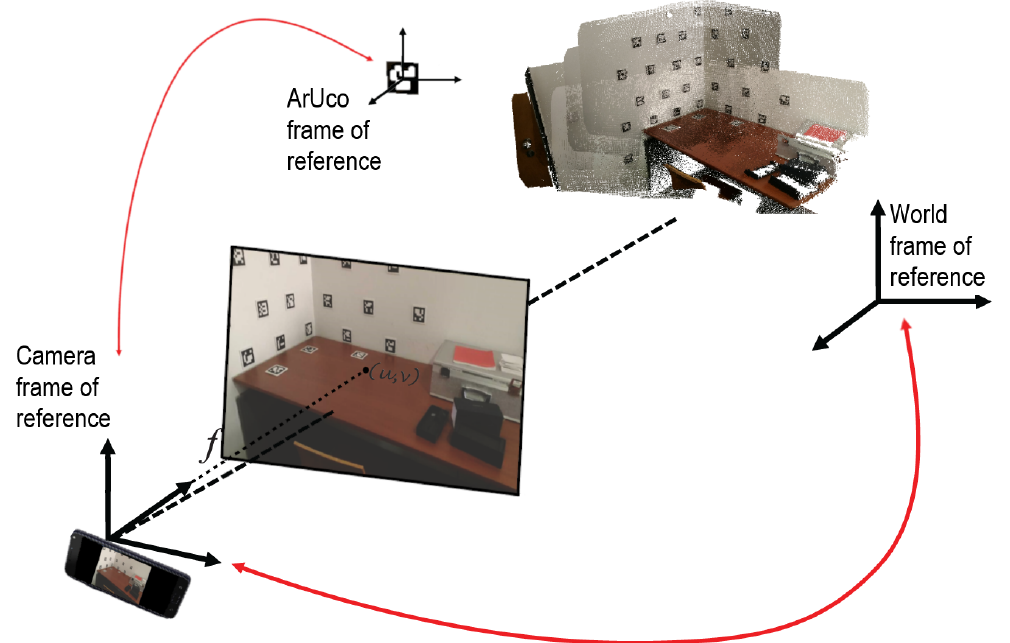
Figure 12. Conversion between different reference frames is used to perform